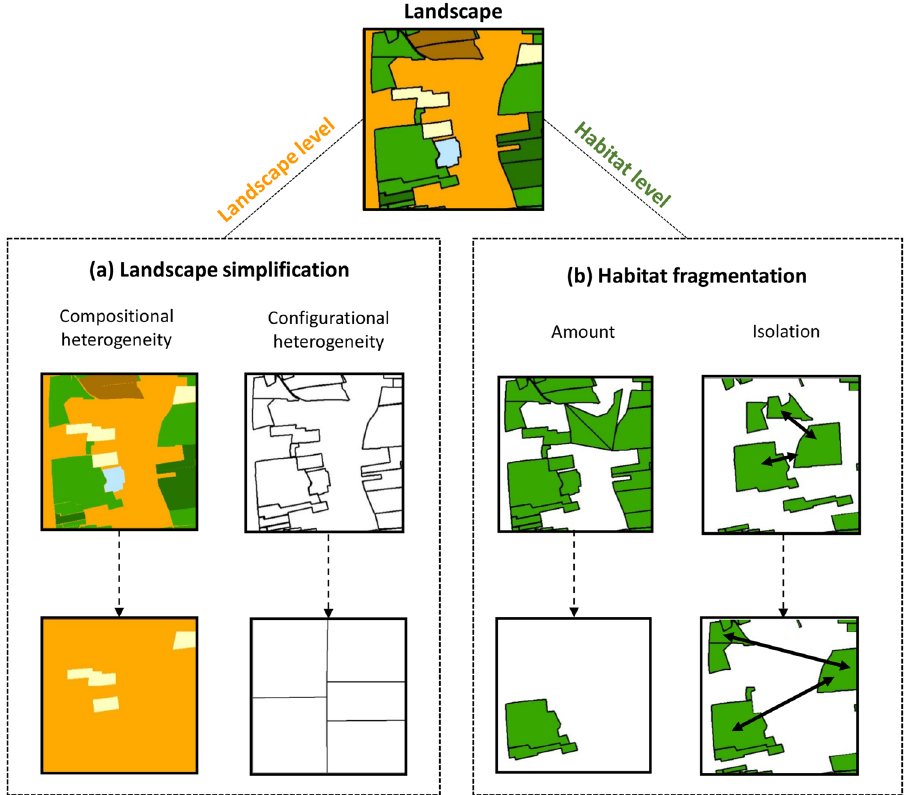
Figure 1. The two processes involved in the definition of landscape structure in the agricultural intensification context. ( a ) Landscape simplification is a process that is measured at the landscape level, where all classes of land use are taken under consideration. It is defined as the reduction in compositional heterogeneity (i.e. habitat diversity) and/or the reduction in configurational heterogeneity (i.e. complexity of the spatial pattern) 2 . ( b ) Habitat fragmentation is a process that is measured at the habitat level, where only one class of land use is taken into consideration. It is defined as a reduction in habitat amount and/or an increase in the isolation of habitat patches 91 . The four dotted arrows represent the direction of an increase in landscape simplification and habitat fragmentation. This figure was created using ArcGIS Software (v. 10.6.1, https ://deskt op.arcgi